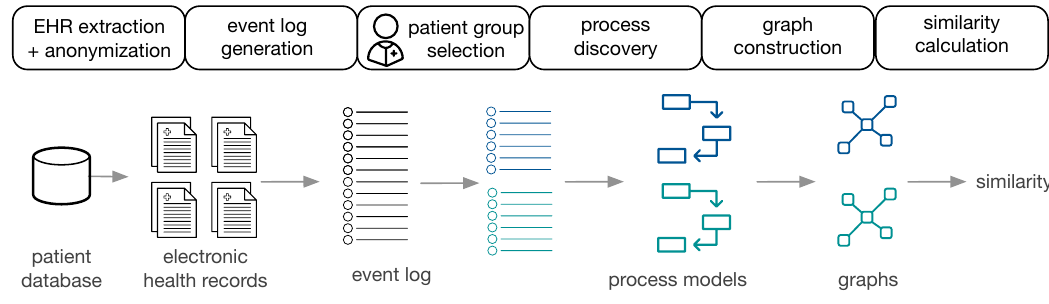
Figure 1. Overview of the